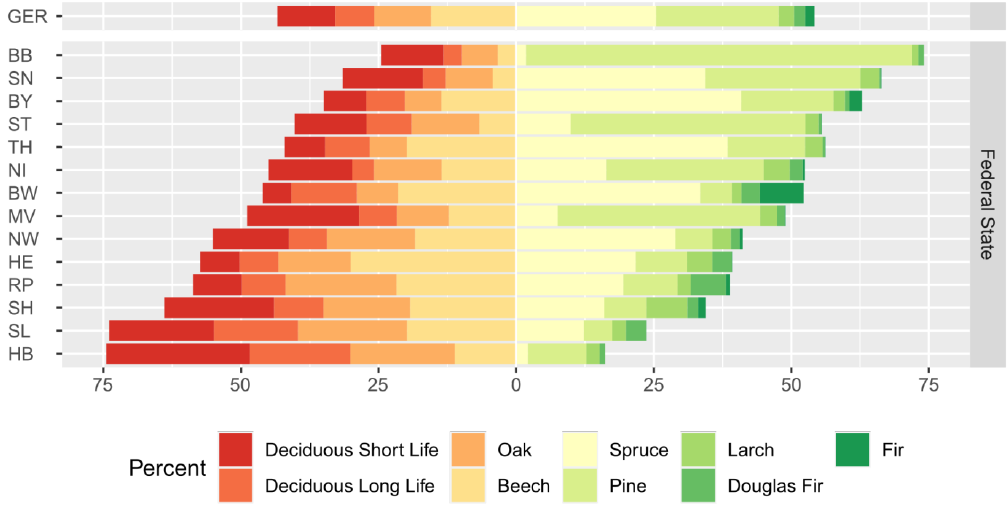
Figure 4. Tree species distribution in Germany per federal state. Orange to reddish colours show deciduous tree species while yellow to greenish colours show coniferous tree species (data source: BWI 2012, https://bwi.info).